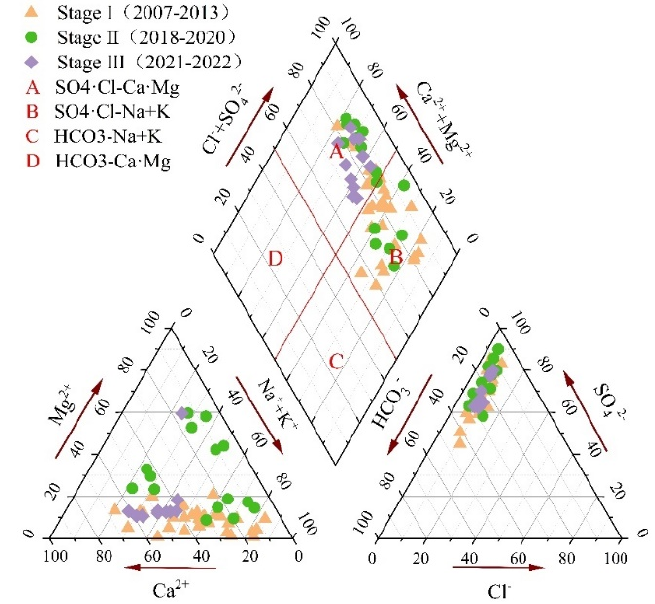
Figure 5. Piper diagram of conventional components of karst groundwater in Taiyuan Formation.